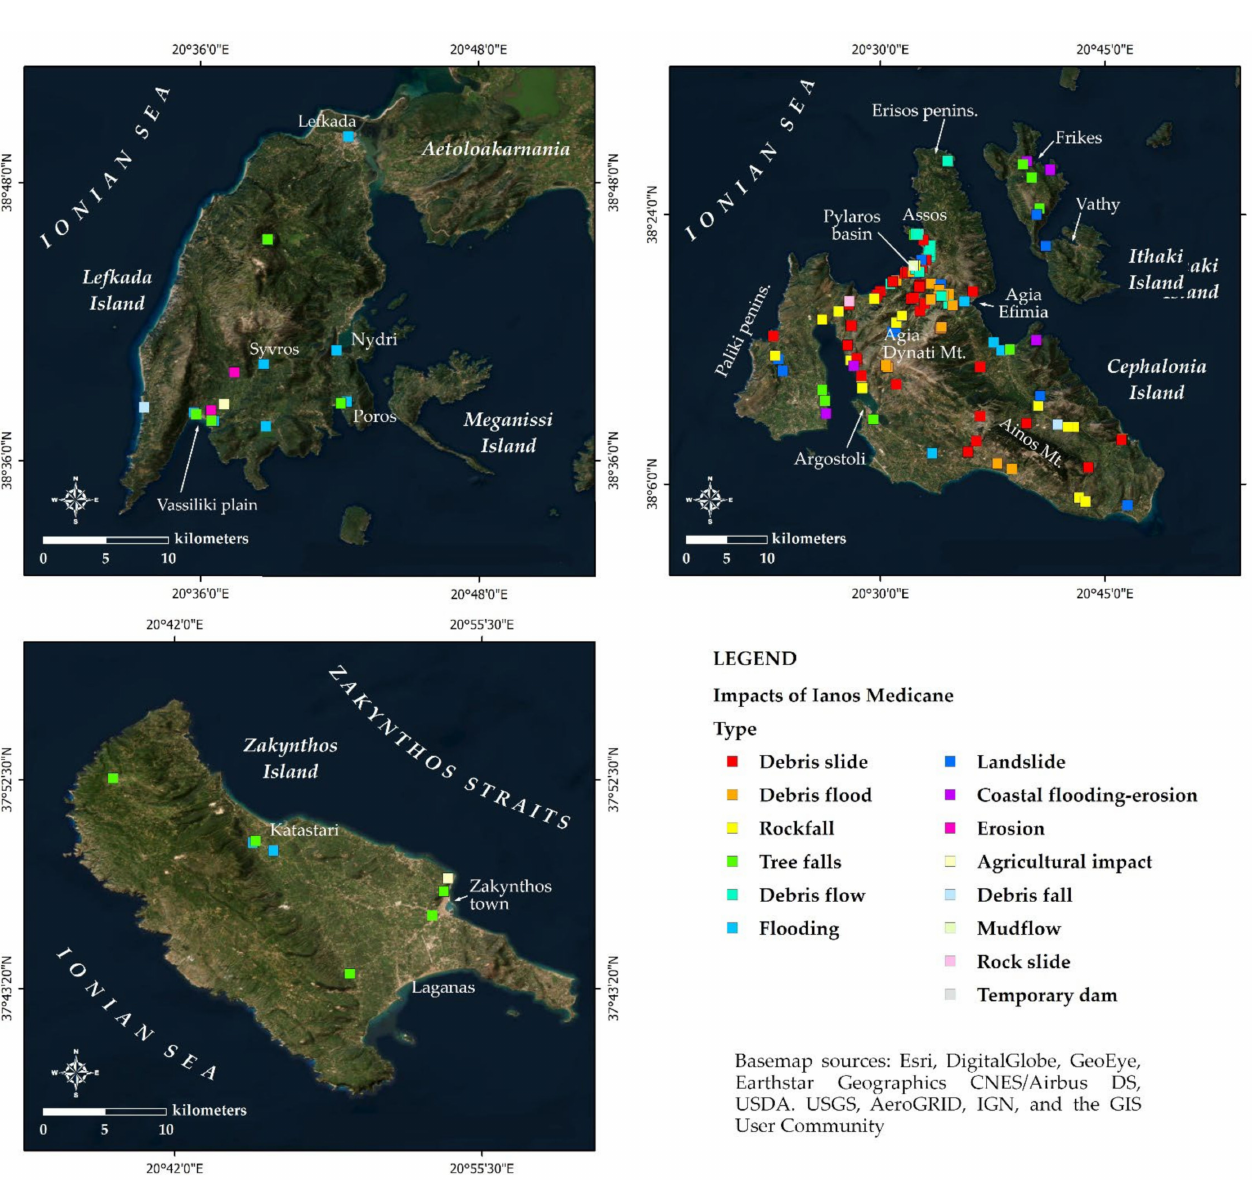
Figure 7. Map of impacts of Ianos Medicane on the natural environment of Ionian Islands, including geomorphic effects and effects on